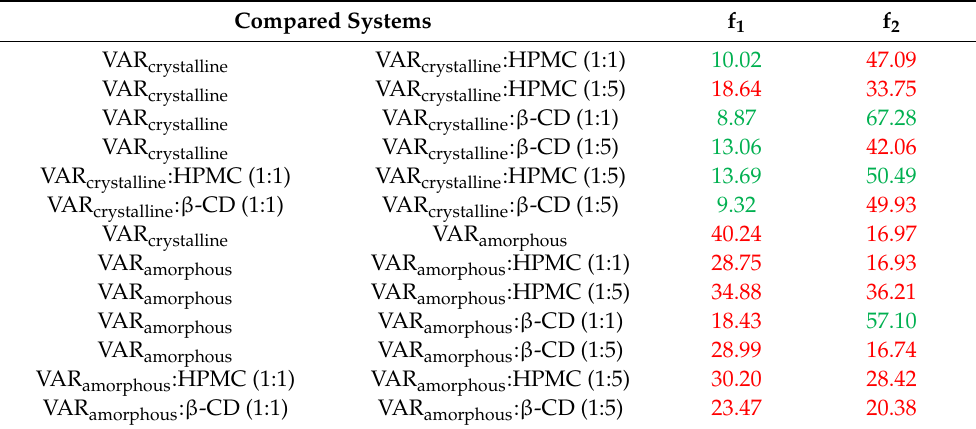
Table 1. The values of f 1 and f 2 for tested systems. Values indicating the difference of the dissolution profiles are red. Values in green indicate their similarity. Compared Systems f 1 f